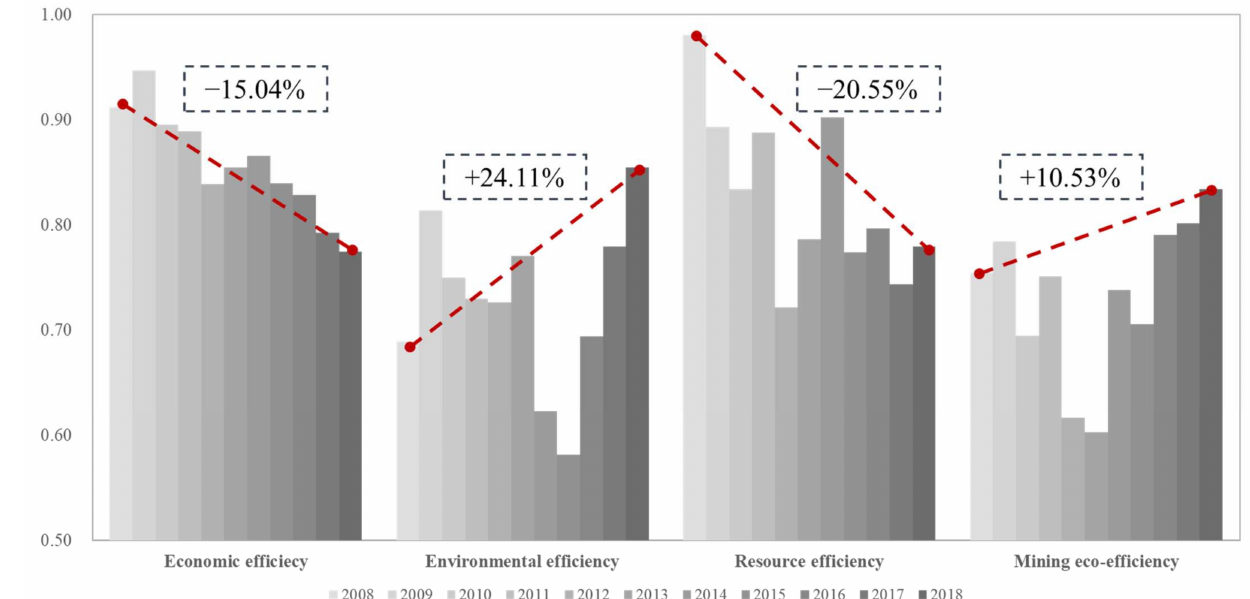
Figure 3. The average value of the eco-efficiency in